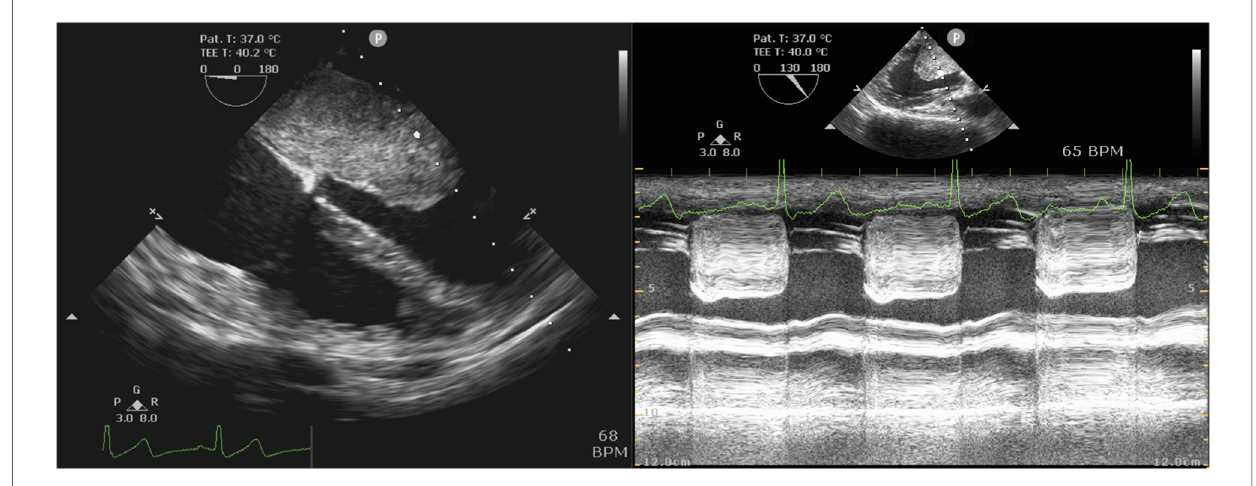
FIGURE 3 Intraoperative TEE examination. Left: Mid-esophageal four-chamber view showed the left atrial myxoma. Right: Mid-esophageal long-axis view by M mode demonstrated mitral obstruction.